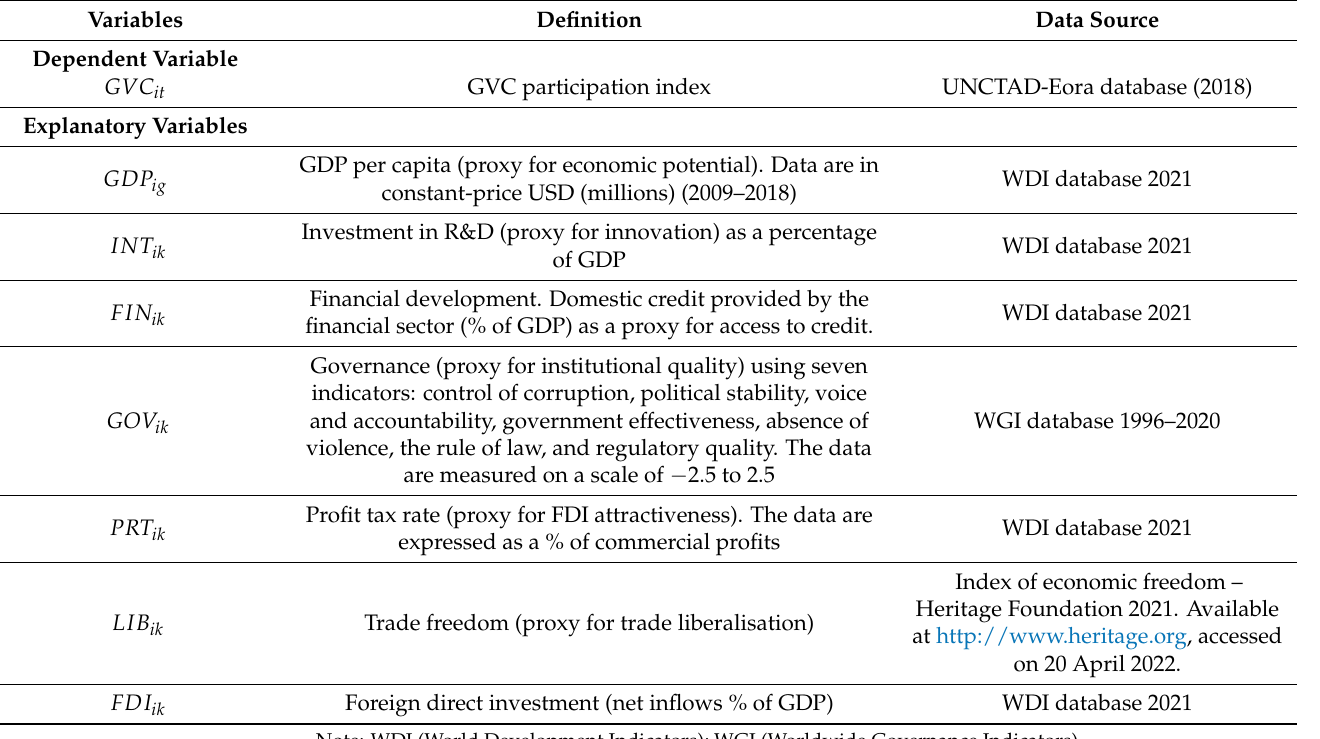
Table 1. Definitions of variables and data